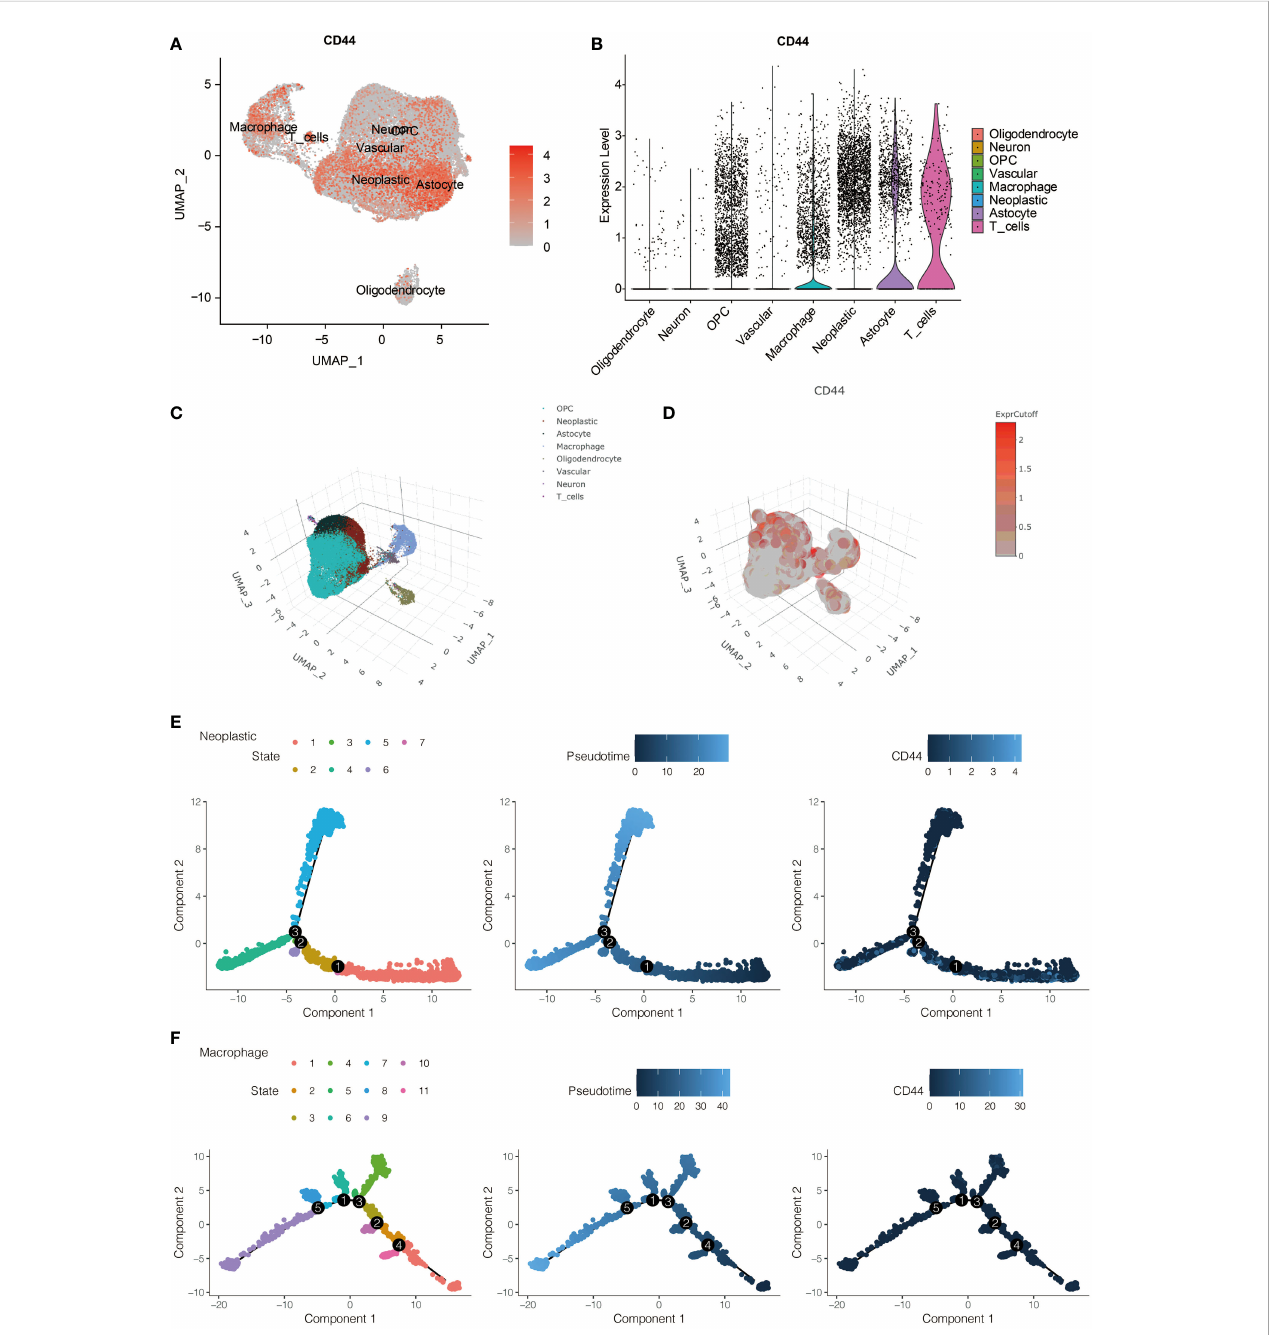
FIGURE 3 The expression pattern of CD44 at the scRNA-seq level. (A) The expression distribution of CD44 in eight types of identi fi ed cells. (B) The expression level of CD44 in eight types of identi fi ed cells. (C) Three-dimension plot of eight types of identi fi ed cells. (D) Three-dimension plot of the expression level of CD44 in eight types of identi fi ed cells. (E) The pseudotime trajectory analysis of glioma cells. (F) The pseudotime trajectory analysis of